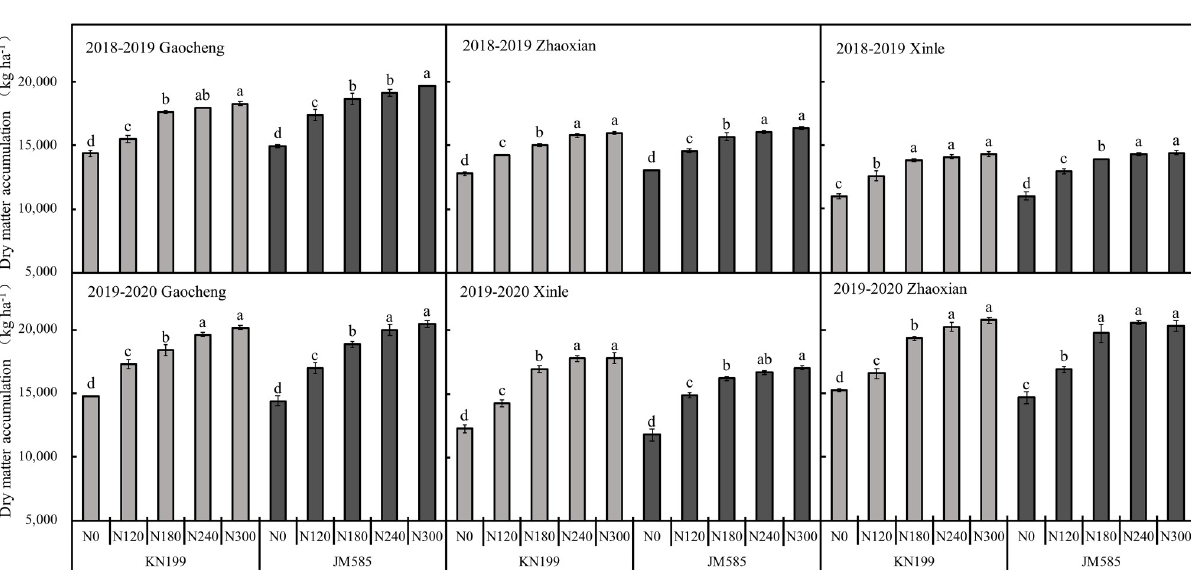
Fig 3. Aboveground biomass at maturity of different winter wheat varieties under different nitrogen fertilization rates in three experimental sites during 2018–2020 seasons. Error bars represent one standard deviation from the mean. Letters above the bars are comparison results of leaf area index between different nitrogen treatments of the same variety. There is no significant difference between treatments with same